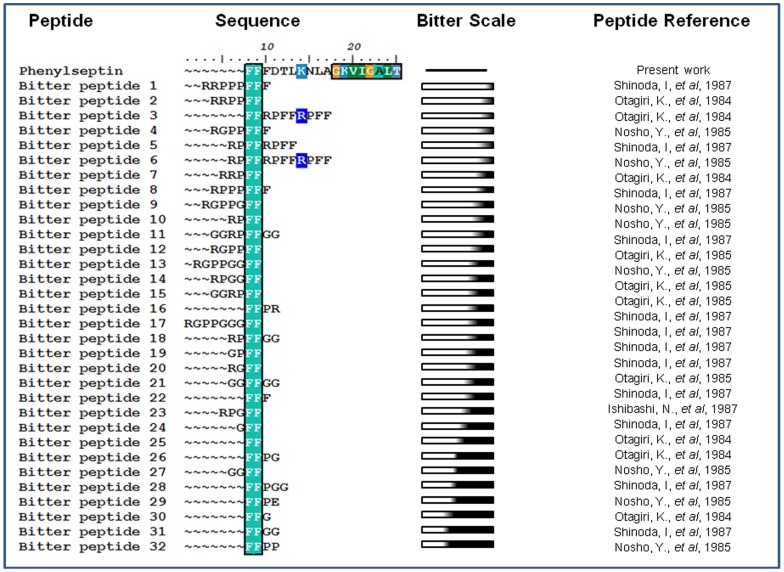
Phenylseptin Phe-Phe-Phe motif.Phenylseptin N-terminal sequence was compared to other peptides previously described on the literature as being bitter. Sequence alignments were edited with the BIOEDIT software. On the right side a bitterness scale based on Kim, et al., 2006 analysis.